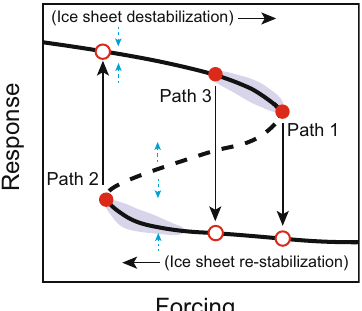
Fig. 6 Schematic stability landscape for ice-sheet destabilization and re- stabilization pathways. Stability diagram showing non-linear responses to forcing. Black solid lines indicate stable equilibria; black dashed line indicates an unstable equilibrium; small blue arrows denote the direction in which the system moves when it is not on the curve (and therefore not in equilibrium). Pathway 1 ( ‘ destabilization ’ ) and pathway 2 ( ‘ re-stabilization ’ ) both show a non-linear change associated with a critical transition (i.e., from red fi lled circle to red hollow circle). Pathway 3 ( ‘ destabilization ’ ), shows ‘ early escape ’ with a tipping point occur prior to reaching the critical threshold. Purple shaded area indicates areas where early warning signals may be